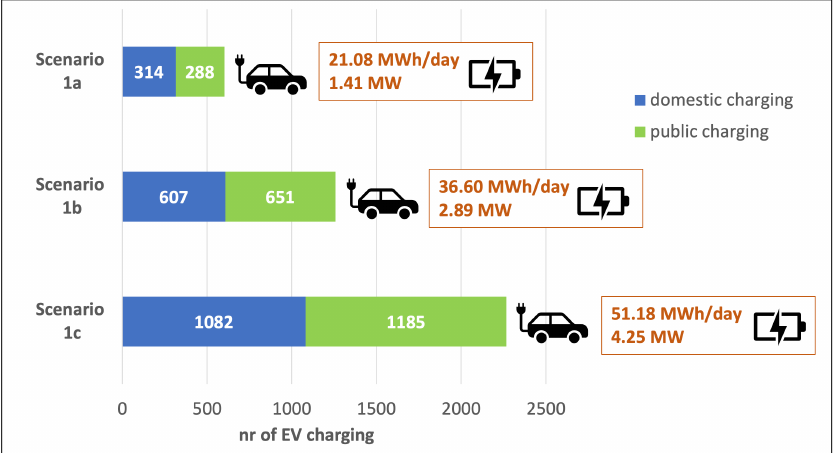
Figure 5. Number of vehicles charging, daily energy and peak demand required to the grid for the different scenarios at 2030.